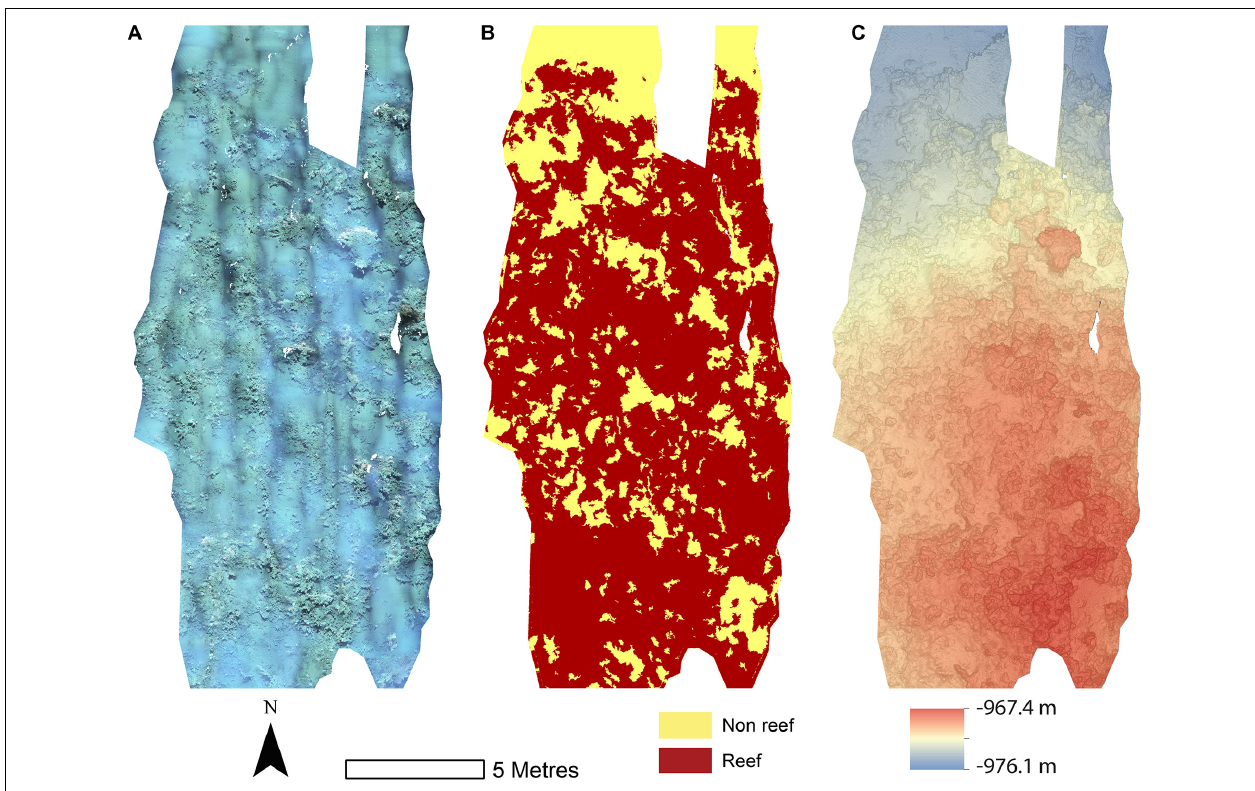
FIGURE 3 | Mosaics of Site B. (A) Orthorectified photomoscaic; (B) Classified substrate map; (C) Digital elevation